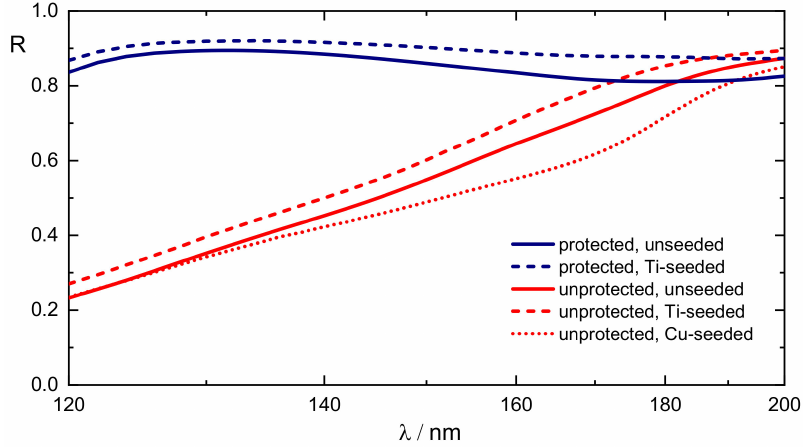
Figure 1. Measured VUV normal incidence reflection spectra of the samples specified in Table